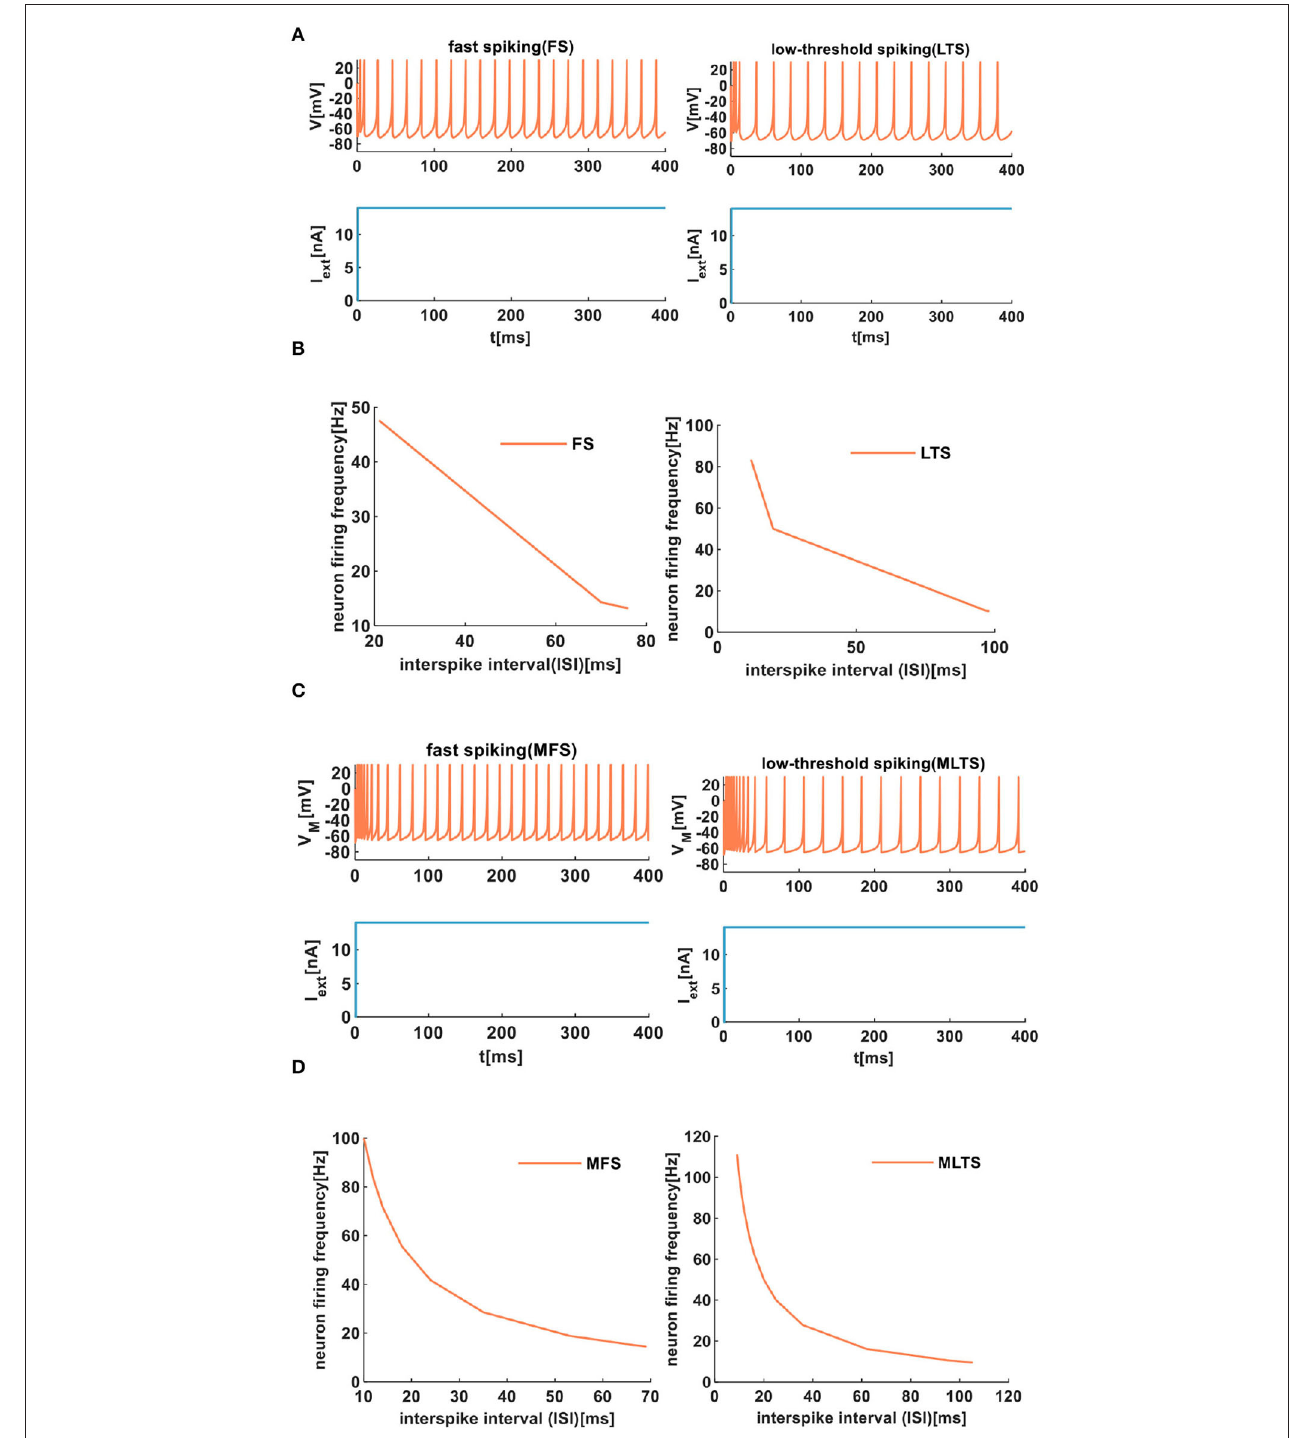
FIGURE 7 | The firing behaviors of inhibitory cortical neurons are produced by the IZH spiking model and the MIZH spiking model. (A) The firing patterns of the inhibitory cortical neurons for the IZH spiking model (the values of parameters are a = 0.04, b = 0.2, c = − 65, d = 8, and I ext = 14 nA for the FS neurons; a = 0.02, b = 0.2, c = − 60, d = 5, and I ext = 14 nA for the LTS neurons). (B) The evolution of the neuron firing rate versus the inter-spike interval for the FS and LTS neurons of the IZH spiking model. (C) The firing patterns of the inhibitory cortical neurons for the MIZH spiking model (the values of parameters are a = 0.1, c = − 65, d = 0.2, and I ext = 14 nA for the MFS neurons; a = 0.05, c = − 65, d = 0.6, and I ext = 14 nA for the MLTS neurons). (D) The evolution of the neuron firing rate versus the inter-spike interval for the MFS and MLTS neurons of the MIZH spiking model.